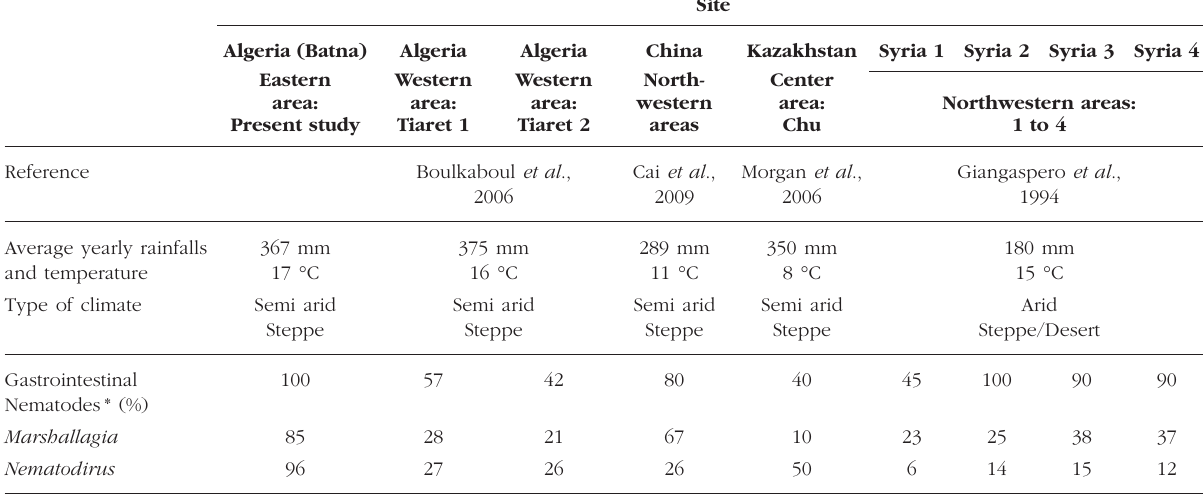
Table I. – Prevalence of nematodes groups in sheep and goats based on faecal egg